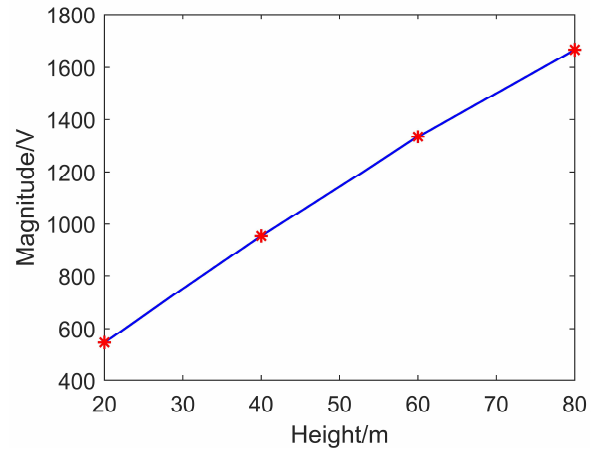
Figure 9. Disturbance voltage level under different cable heights.